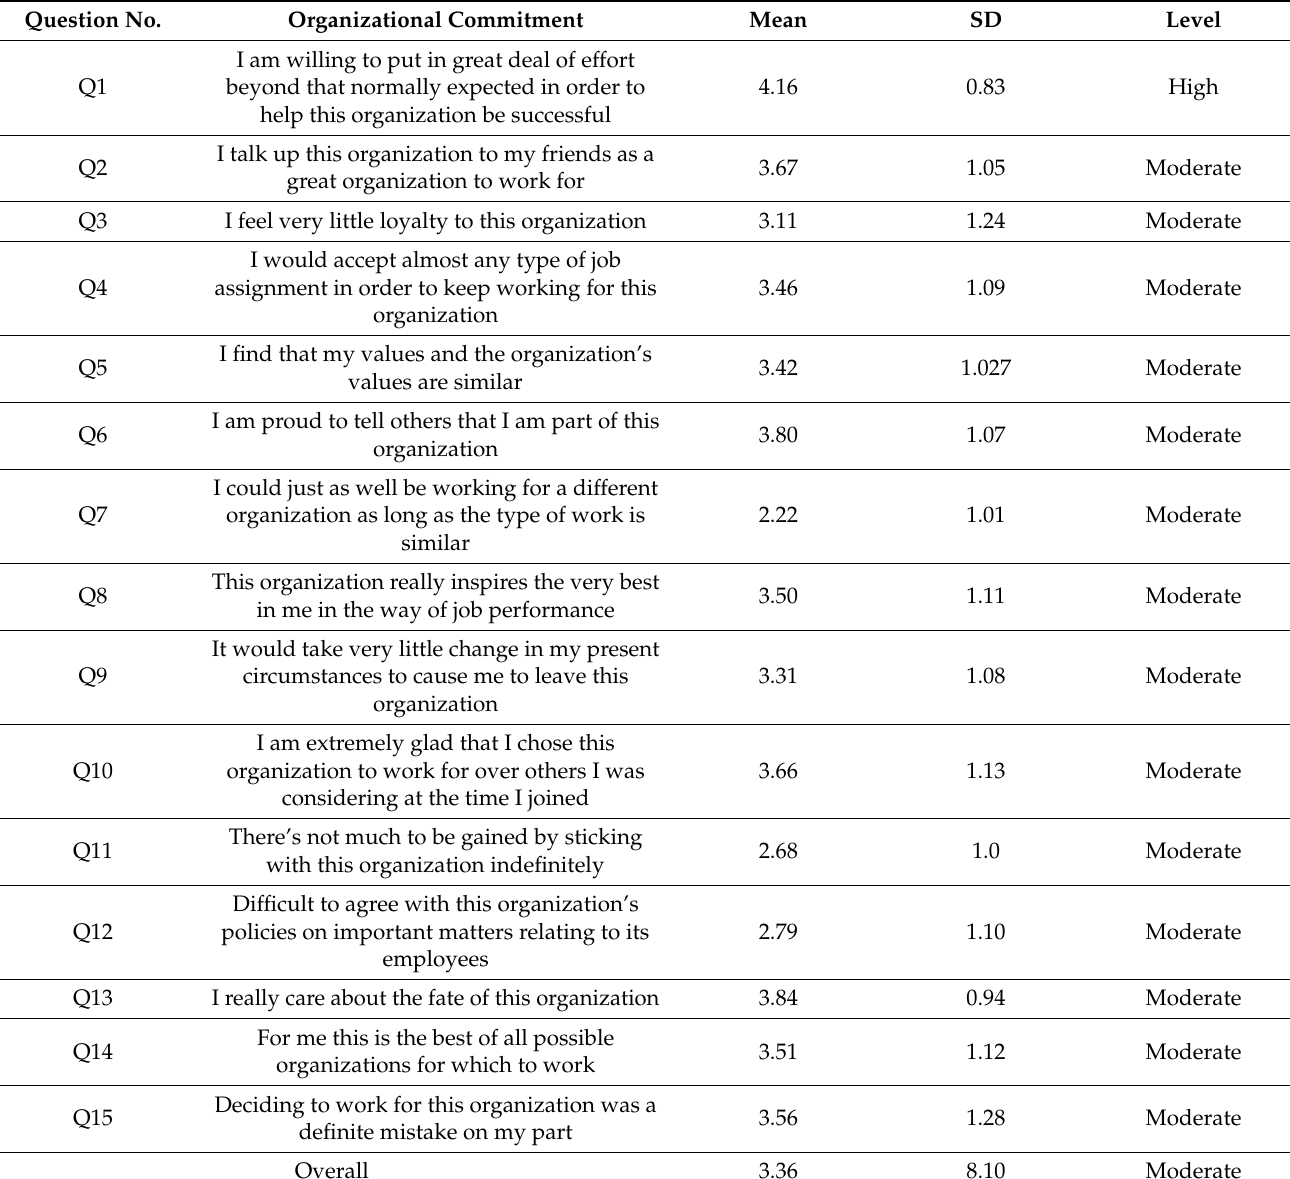
Table 3. The mean and standard deviation for the level of overall organizational